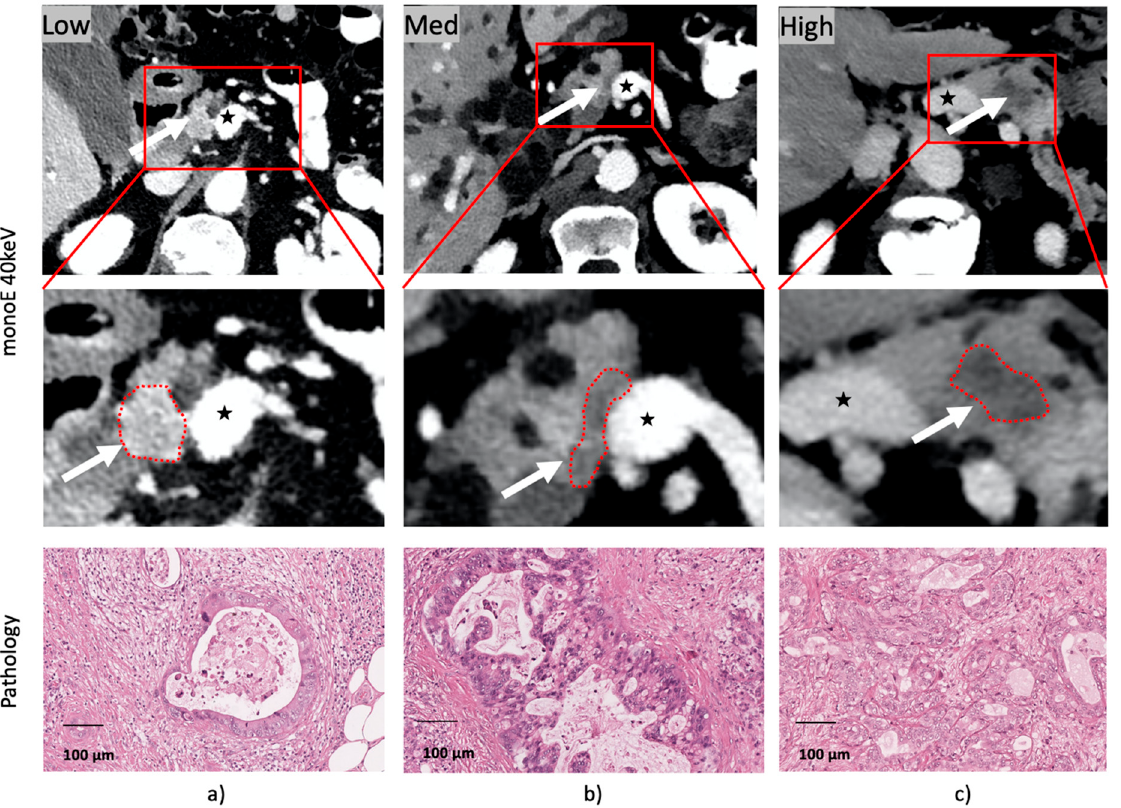
Figure 3. Micrographs of corresponding regions in histopathologic specimen and CT imaging for ( a ) low, ( b ) intermediate and ( c ) high cellularity level. The upper row shows the corresponding tumor region in an axial slice of the monoE 40 keV CT reconstruction. The center row depicts the zoomed in area marked in the upper row. Window settings (level/width): 50/350 for conventional CT, 250/350 for monoE 40 keV. The microscopic views of matched histopathologic cellularity regions are shown in the bottom row. Scale bar 100 µm. The tumor region in the CT images is identified by the white arrow in the upper row and by a red dotted line in the center row. The superior mesenteric vein is marked by a black star.